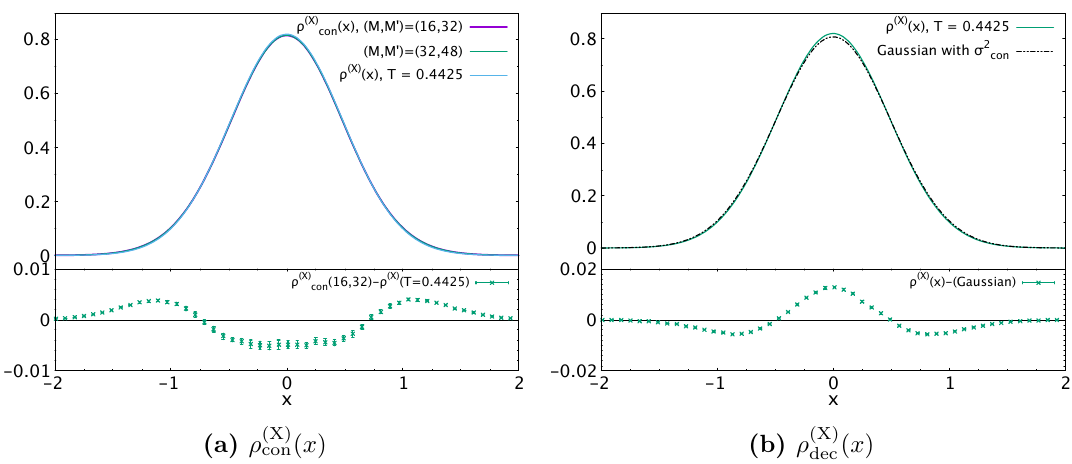
Figure 24. (a) Comparison between ρ (X) ( x ) at low temperature ( T = 0 . 4425 ≈ 0 . 5 · T c ) and the distribution ρ (X) con ( x ) at T = 0 . 885 . The histogram ρ (X) ( x ) is made using 500 configurations, while ρ (X) con ( x ) is identical to the one in figure 10. (b) Comparison ρ (X) ( x ) at T = 0 . 4425 with the Gaussian distribution. The variance is chosen as σ 2 = 0 . 244 . The error bars in each figure are obtained by con jackknife